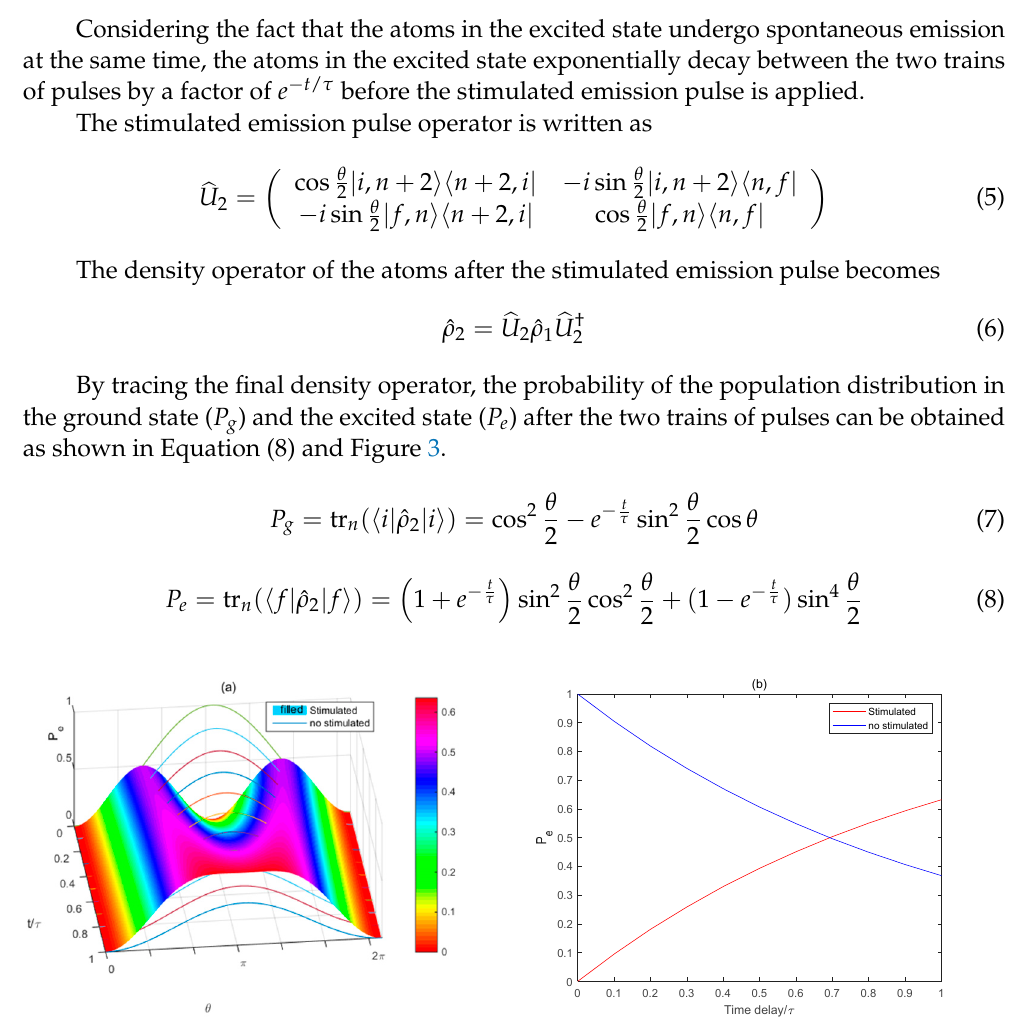
Figure 3. The probability of the population distribution in the excited state varies with the pulse area and the time delay of the stimulated emission pulse simultaneously. The curved surface graph in ( a ) and the red line in ( b ) indicate the case in which the stimulated emission pulse is applied, whereas the curved line graph in ( a ) and the blue line in ( b ) indicate that there is no stimulated emission pulse.